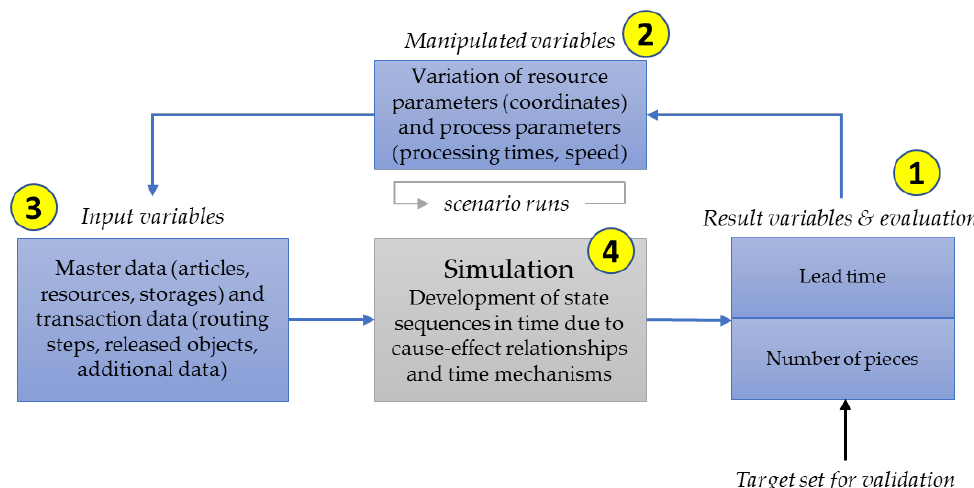
Figure 8. Procedure for the validation of the generic simulation.